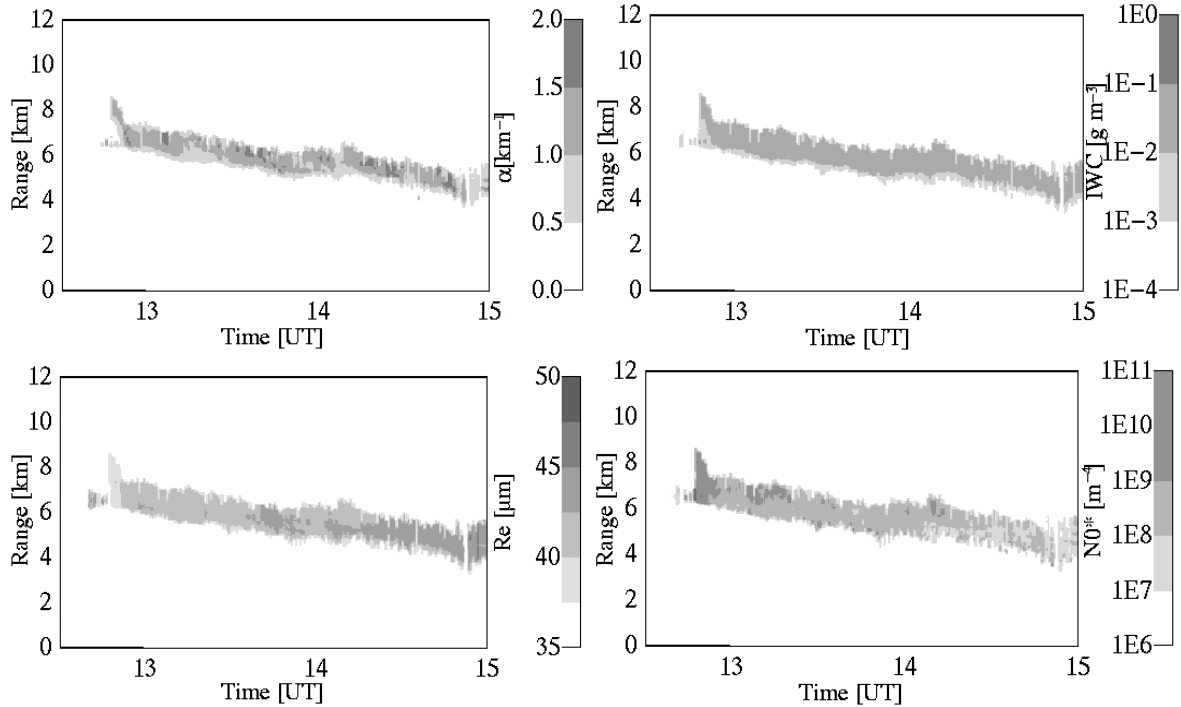
Fig. 6. Cloud microphysical properties retrieved from the radar-lidar algorithm on 1 April 2003: (a) lidar extinction coefficient (km − 1 sr − 1 ), (b) ice water content (gm − 3 ), (c) particle effective radius (mm), (d) intercept of particle size distribution No*.(m − 4